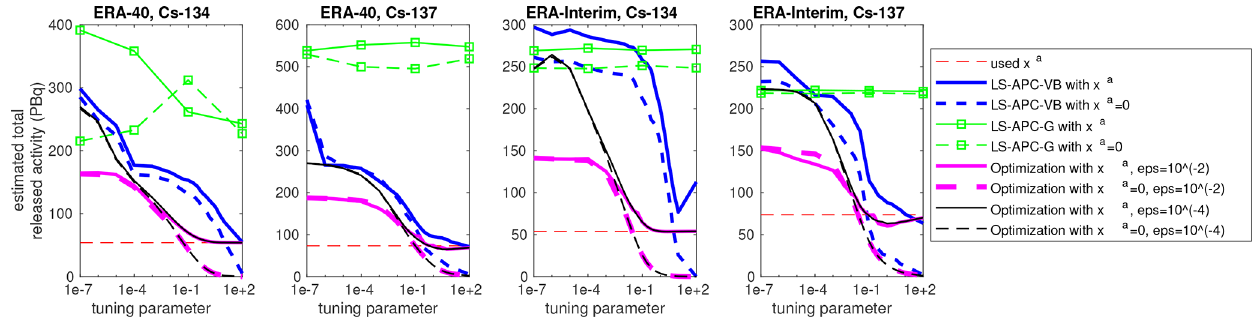
Figure 9. Estimated total released activities for both meteorological reanalyses (ERA-40 and ERA-Interim) and both nuclides (Cs-134 and Cs-137) using all tested methods; see the label bar on the right for a line description.